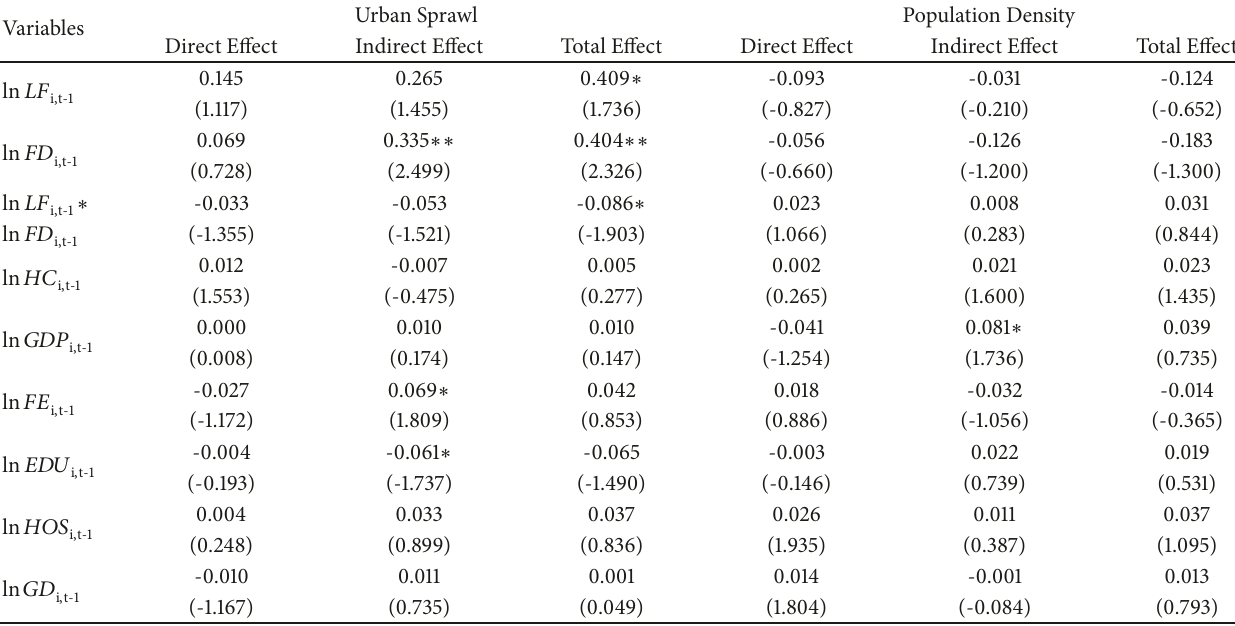
Table 8: The direct, indirect, and total effects of the western